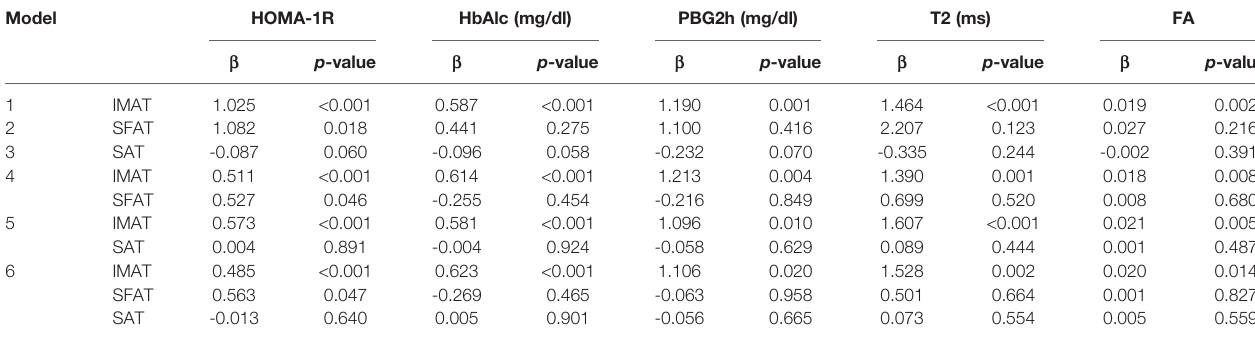
TABLE 5 | Association between thigh fat composition and muscle magnetic resonance parameters and type 2 diabetes markers (N = 24).